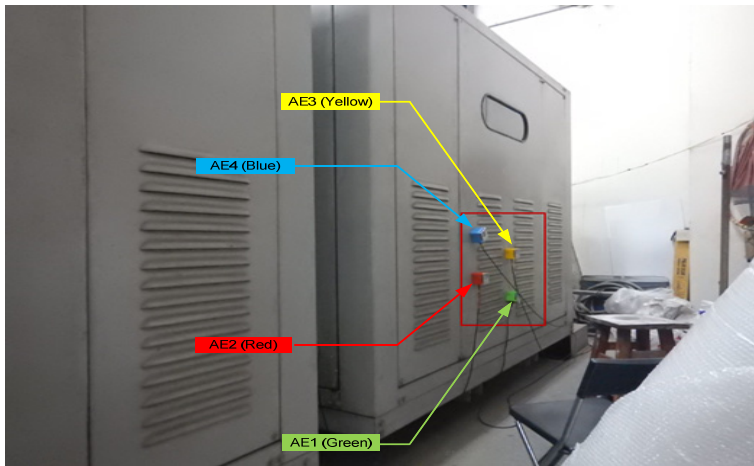
Figure 9. The four AE sensor installation on housing of high side transformer.